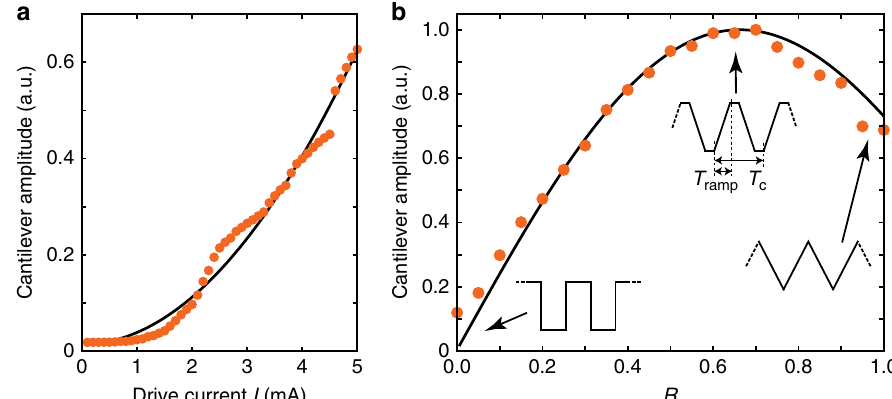
Figure 3 | Demonstration of v FM. ( a ) Signal as a function of drive current amplitude, well below magnetic saturation of the pole. Solid line is p I 2 . Small deviations from the square law are probably due to domain switching and hysteresis. ( b ) Signal amplitude while changing the current modulation from rectangular ( R ¼ 0) to triangular ( R ¼ 1), as sketched in the figure. R ¼ 2 T ramp / T c is the fraction of time spent on ramping the